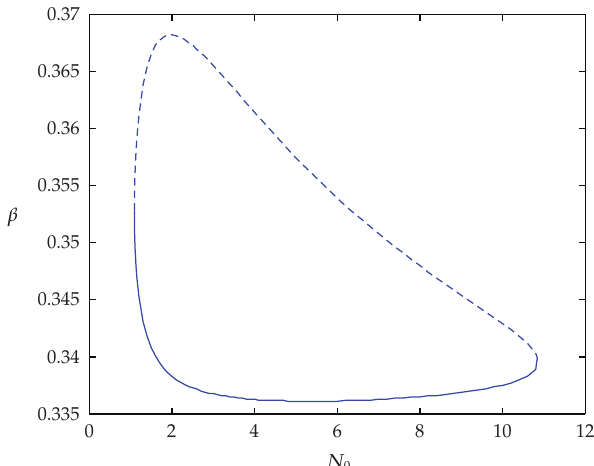
Figure 2: The Hopf curve: The curve shows the location in (cid:5) N 0 ,β (cid:6) space at which oscillatory solutions are born. The smooth line shows the supercritical Hopf points and the dashed lines shows the subcritical Hopf points. Here α (cid:7) 0 . 4, γ (cid:7) 1 . 2, δ (cid:7) 0 . 4, η (cid:7) 0 . 01, c b 0 (cid:7) 0 . 1, c p 0 (cid:7) 0 . 1, μ (cid:7) 0 .